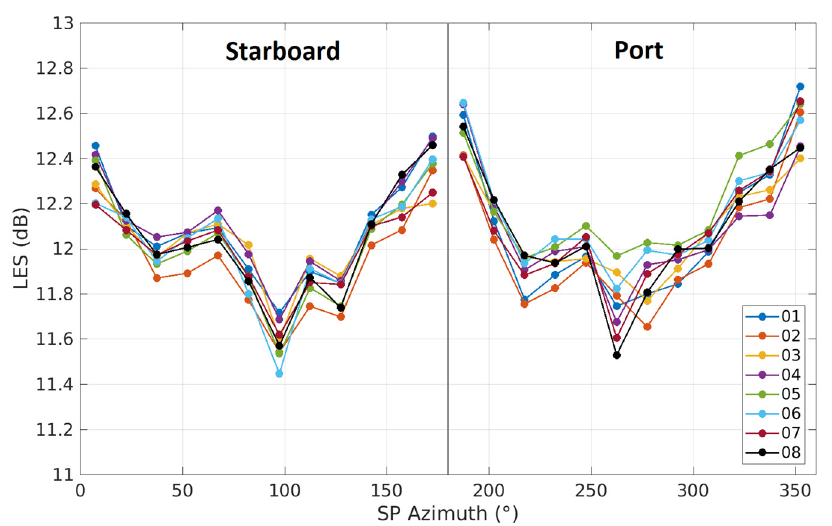
Figure A3. Dependence of leading edge slope (LES) on azimuth, segmented by CyGNSS receiver (FM01-FM08), at U10 ~7 m/s, for all SVNs, from the starboard (left panel) and port (right panel) nadir antennas.